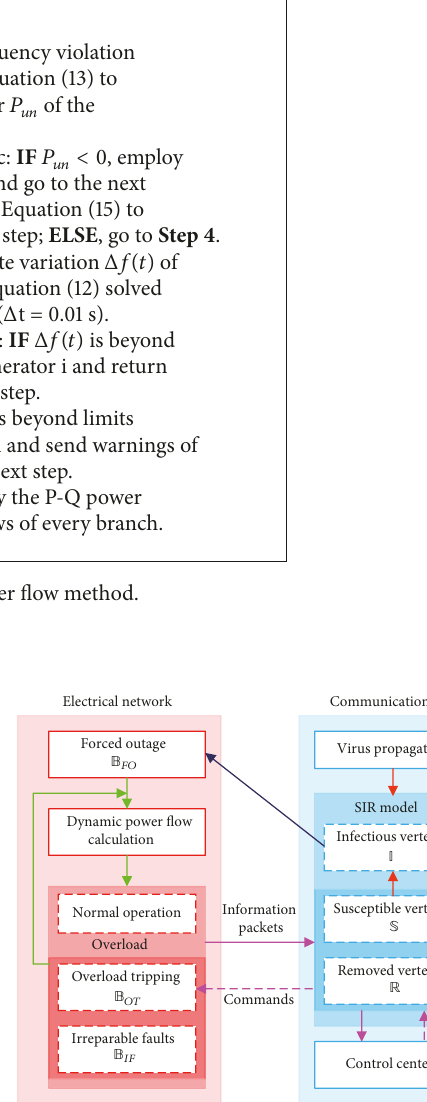
Figure 3: Cascading failures considering interactions between